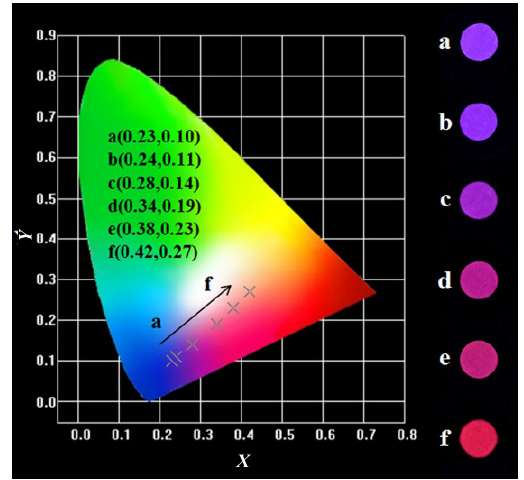
Fig. 11 CIE chromaticity diagram of Ba 0.79 Al 10.9 O 17.14 : 0.04Eu, y Li + ( y = 0.04–0.14) and digital images in UV box.